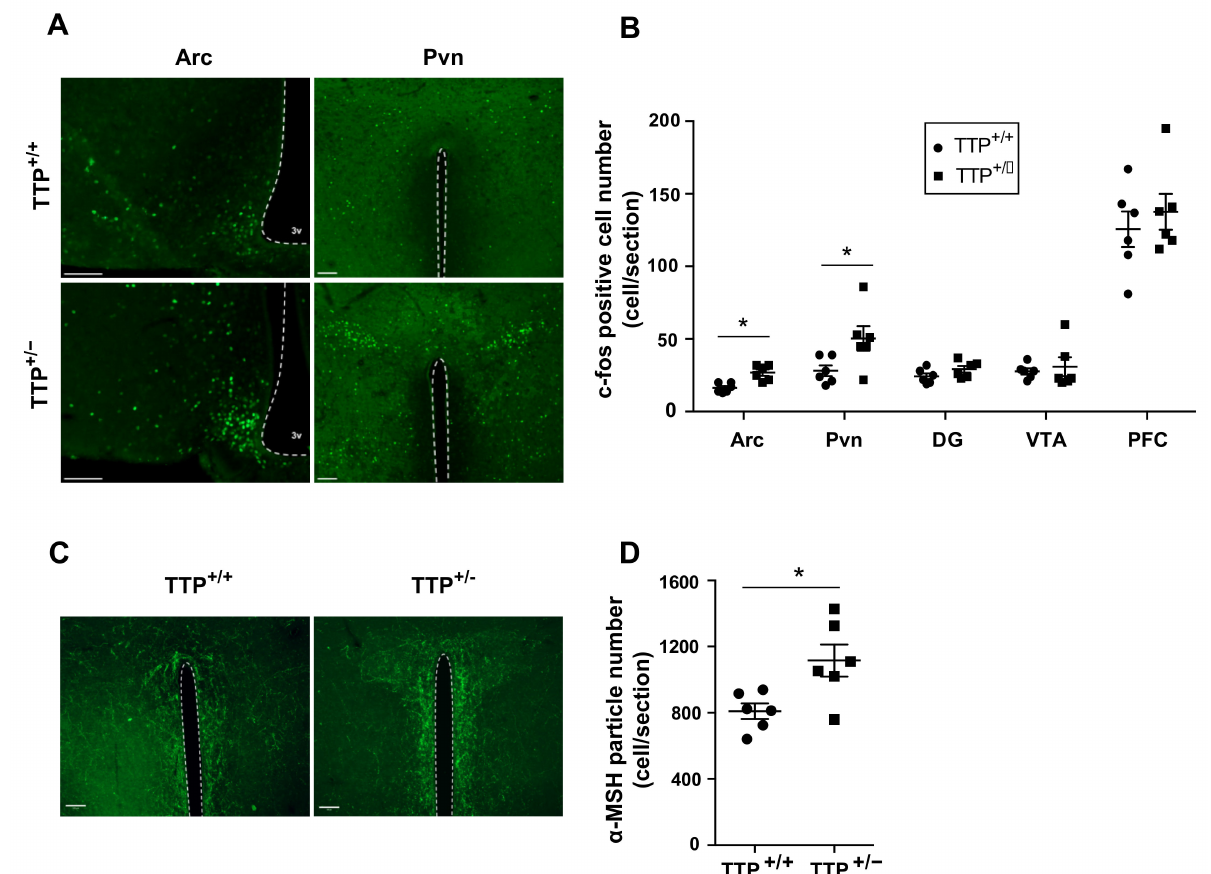
Figure 5. Deficiency of TTP leads to enhanced immunosignals of c-fos and alpha-melanocyte-stimulating hormone (MSH) fibers in the hypothalamic Arc and Pvn. ( A ) Representative images reveal immunosignals of c-fos, a marker for neuronal activation, in the hypothalamic Arc and Pvn as determined by IHC. ( B ) A higher number of c-fos positive cells in the hypothalamic Arc and Pvn of the TTP-deficient mice compared to that of wild type mice. No significant alteration of c-fos positive cells was found in the DG, VTA and PFC of the TTP-deficient mice compared to that of wild type mice. ( C ) Representative images obtained by IHC show increased immunosignals of α -MSH fibers in the hypothalamic Pvn. ( D ) The number of α -MSH fiber signals was elevated in hypothalamic Pvn of the TTP-deficient mice compared to that in wild type mice. Data are presented as the mean ± SEM. n = 6 mice per group. * p < 0.05. Scale bar = 100 µ m. SEM; standard error of the